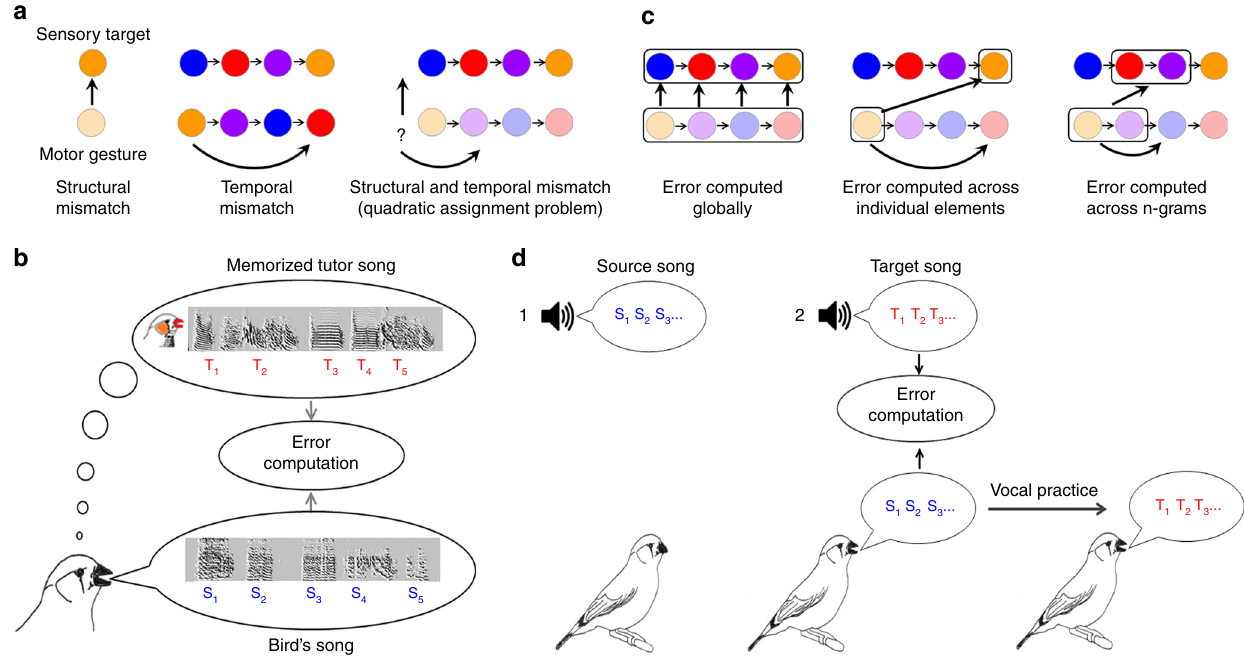
Fig. 1 Motor sequence learning: hypotheses and testing method. a Sensorimotor learning may require adapting the structure of a motor gesture to a desired target (left, different colors indicate a structural mismatch); adapting the temporal order of gestures to a target sequence (middle); or adapting a sequence of unformed gestures to a target sequence (right). In the latter case, the number of possible combinations of structural and temporal adjustments (vertical and horizontal arrows) increases exponentially with sequence length. b Song learning in zebra fi nches: a juvenile male gradually matches its own unformed vocalizations (bottom sonogram) to a memorized song of a tutor (top sonogram). Letters represent consecutive syllables of the bird ’ s song (S 1 , S 2 … ) and the target (T 1 , T 2 … ) c Hypothetical strategies of motor sequence learning: left, motor gestures are matched to temporally corresponding target gestures; middle, gestures are matched to the most structurally similar targets, minimizing structural changes, but possibly requiring considerable sequential rearrangements; right, error is computed across ‘ chunks ’ of gestures attempting to achieve local (non-optimal) tradeoffs between structural and temporal adjustments. d Experimental setup for testing vocal learning strategies. Left, a young bird hears a playback of an arti fi cial song (source); once he learns it (middle), training is switched to a playback of a second song (target). The mismatch between the two songs is designed by the experimenter. The bird ’ s vocal practice trajectory as it corrects the mismatch is continuously